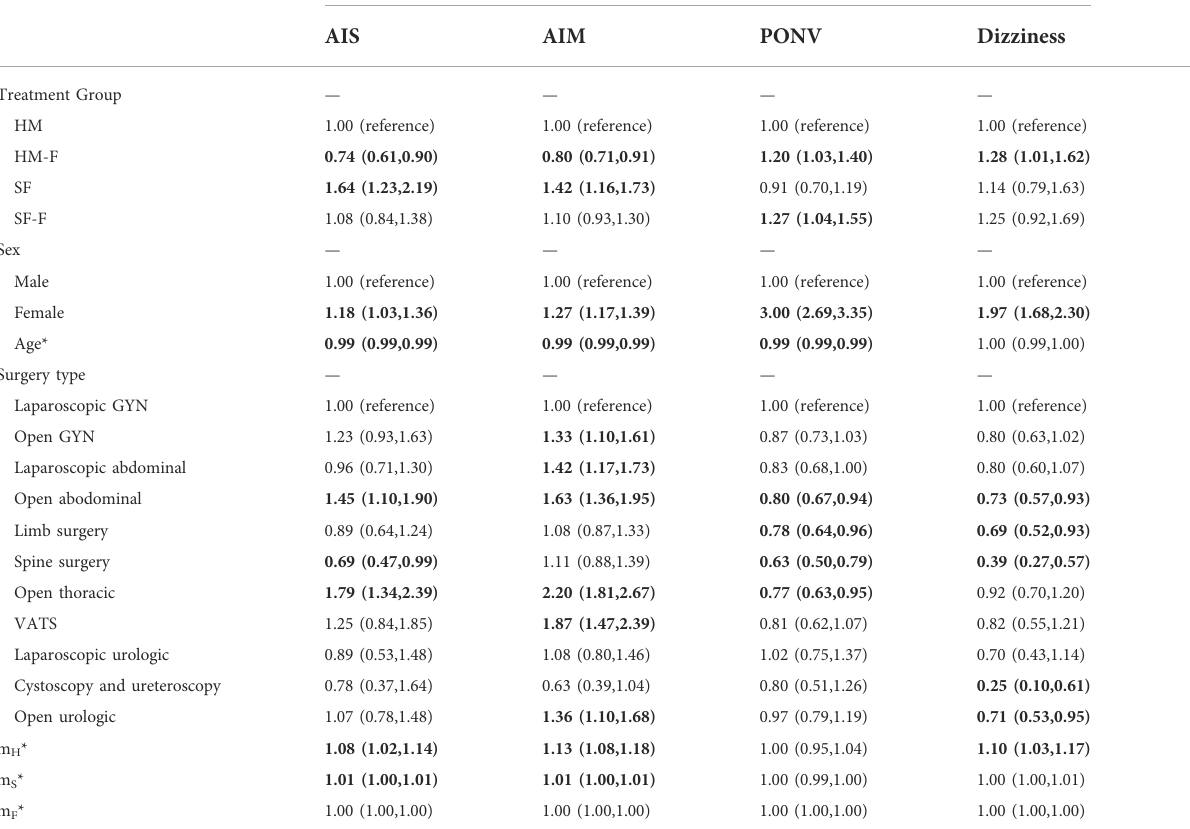
TABLE 2 Multivariable analysis of factors associated with the primary outcome and secondary